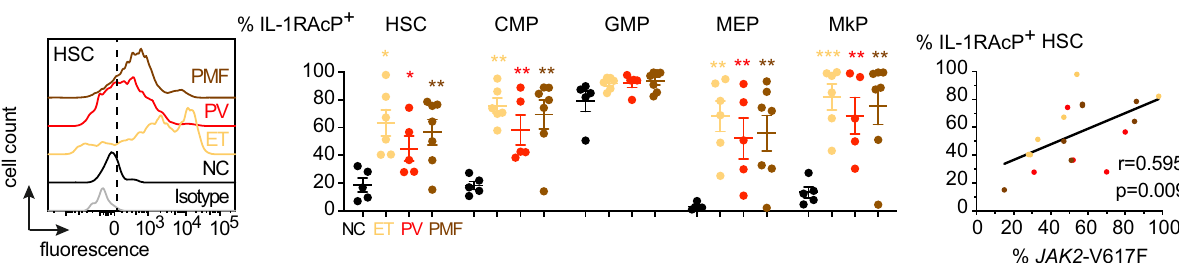
Frequency of IL-1RAcP-positive HSPCs in peripheral blood and correlation with JAK2- V617F allele burden